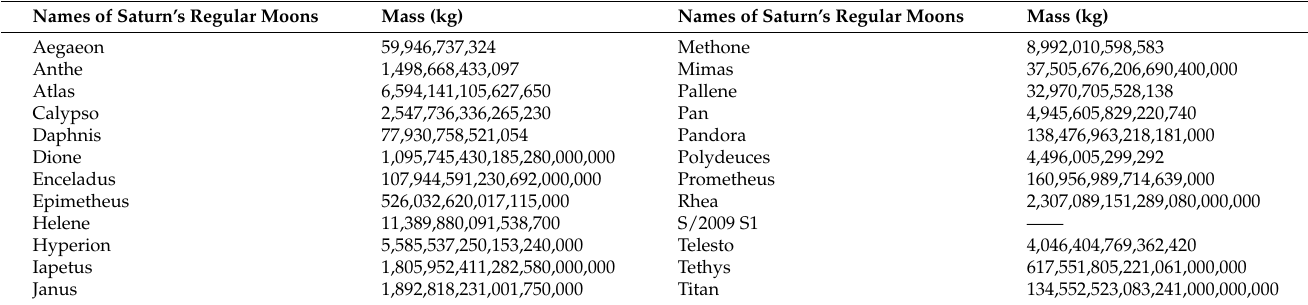
Table 1. Mass data of Saturn’s regular